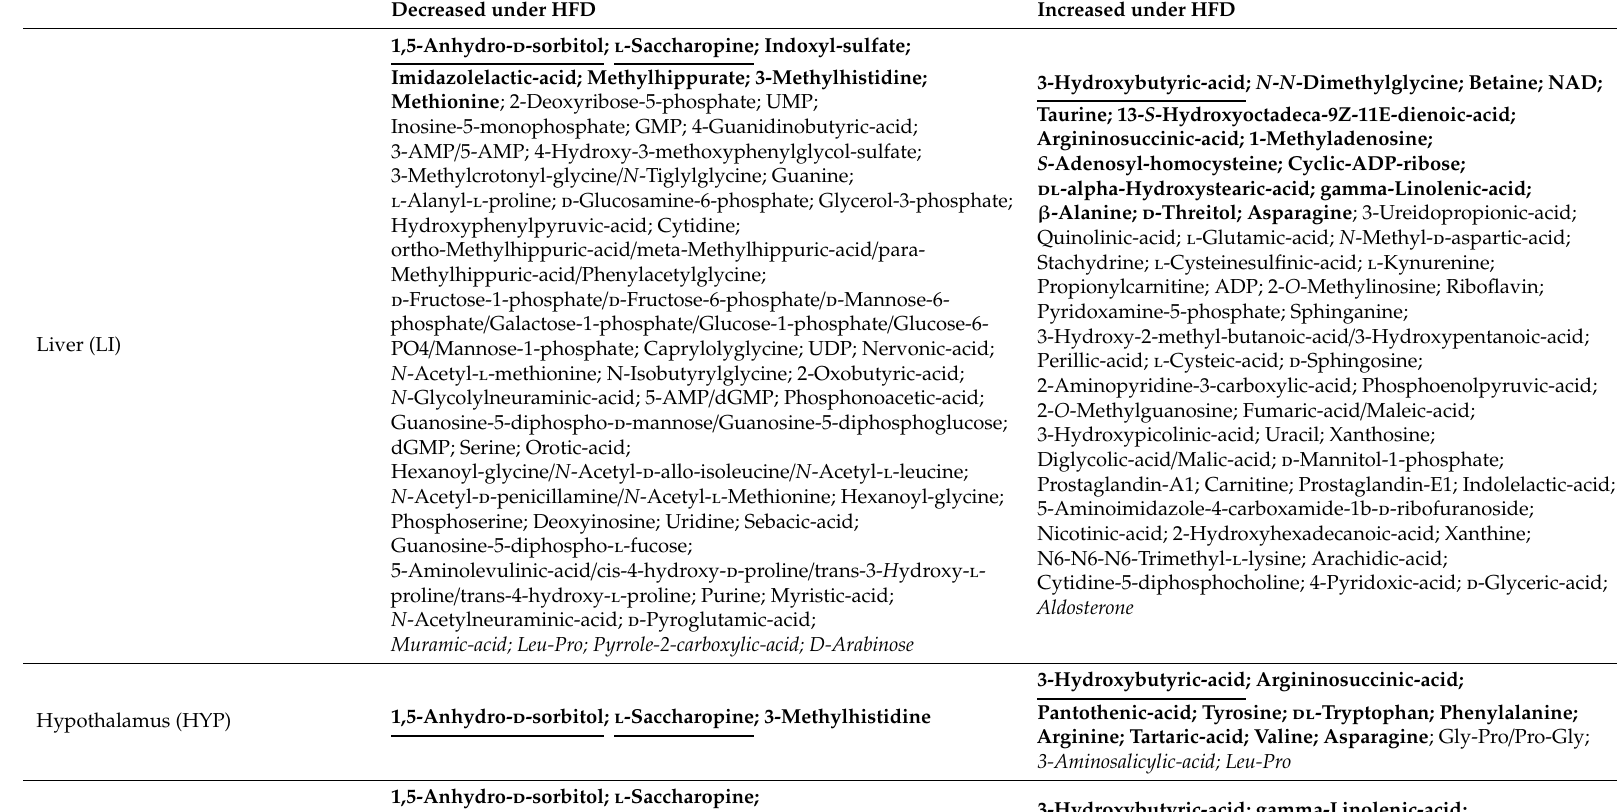
Table 1. Discriminating metabolites between CD-fed and HFD-fed male